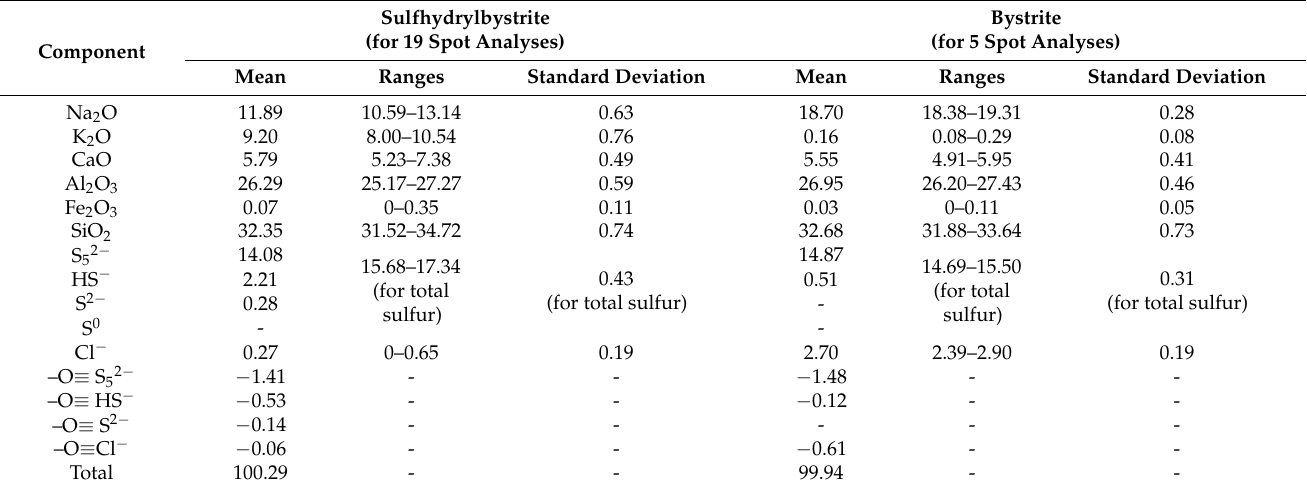
Table 2. Chemical composition (wt.%) of bystrite (Sample 9) and sulfhydrylbystrite (Sample 11).